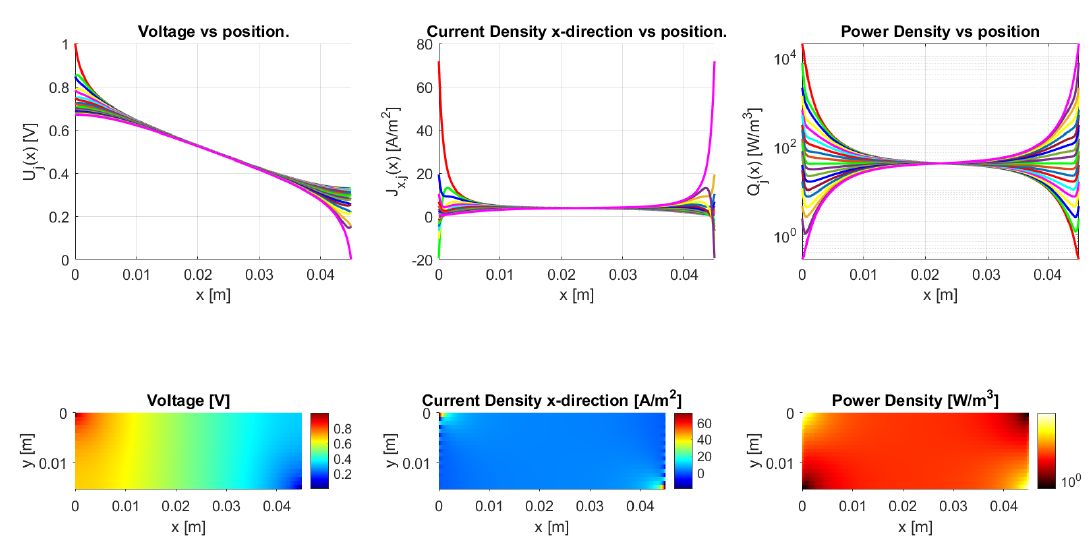
Figure 24. Model results for a meandering, long, slender structure with traxels of 45mm long and an aspect ratio of 0.338. The anisotropy ratio is taken to be Γ ≈ 1 by taking σ = 2 × 10 − 8 Ω m 2 . The voltage drop is mainly from left to right.